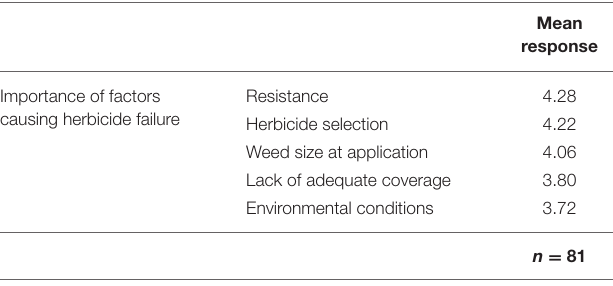
TABLE 8 | Reported Echinochloa crus-galli (L.) P. Beauv. densities if herbicides were to not be applied (germination potential within a given year based on the